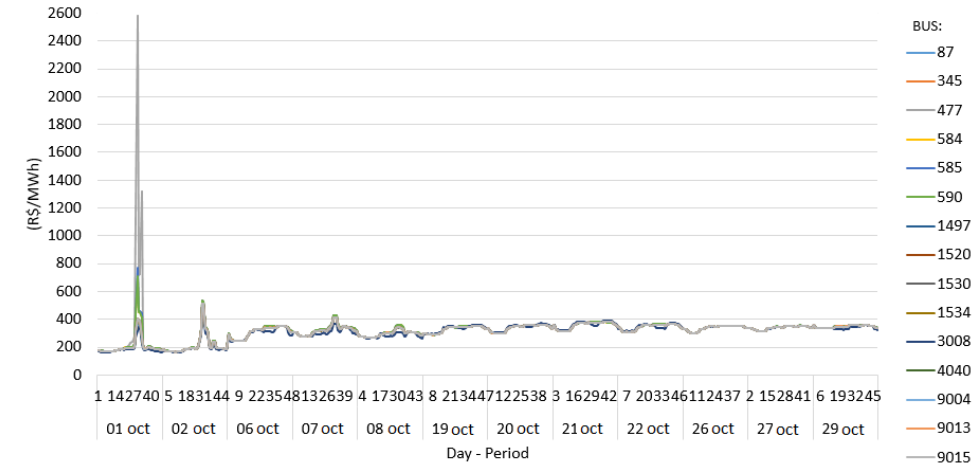
Figure 3. Southeast /Midwest BMC values on base case.